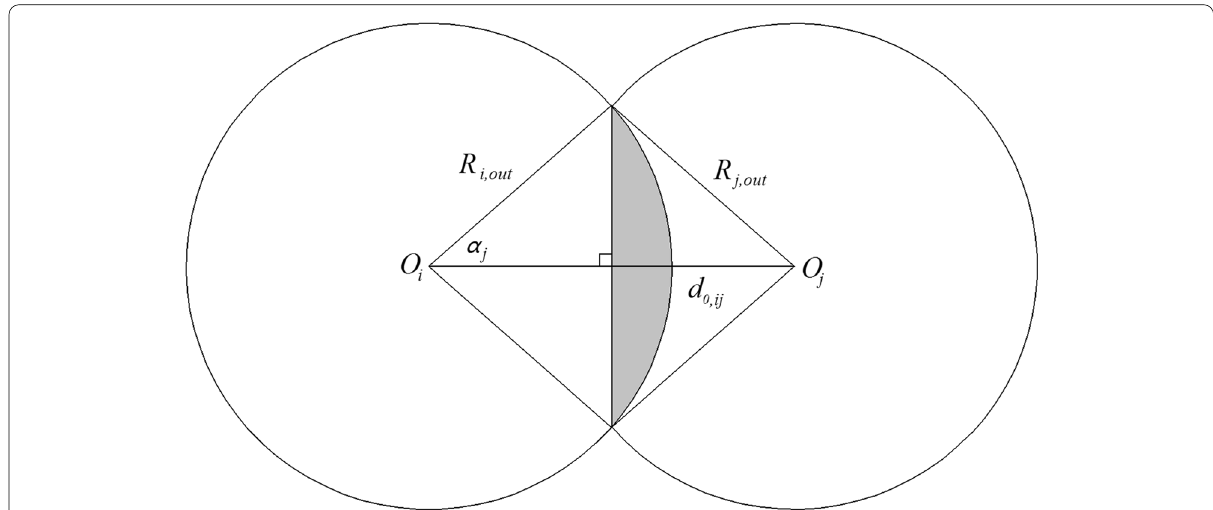
Fig. 2 Schematic diagram of the positional relationship between two mutually interfering particles.